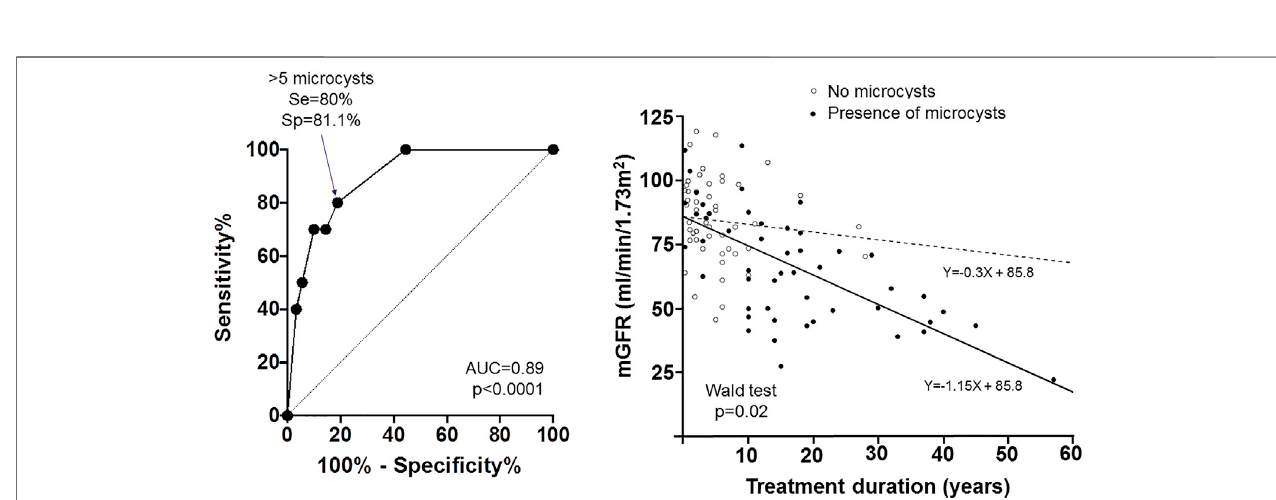
FIGURE3| Accuracyofrenalmicrocystsinthediagnosisoflithium-relatedchronickidneydisease.Leftpanel:ROCCurveshowingthesensitivityand1 — speci fi city ofrenalmicrocystsquanti fi cationforthediagnosisofmGFR < 45 ml/min/1.73 m 2 .Thecut-offvalueof5microcystshadthehighestYoudenIndex,withasensitivity(Se)of 80%andaspeci fi city(Sp)of81.1%.Rightpanel:GFRvaluesaccordingtotreatmentdurationandregressionlinesinpatientswith( fi lledcirclesandblackline)andwithout (open circles and dashed line) microcysts. A Wald test was performed to test the difference in slopes between the two groups.